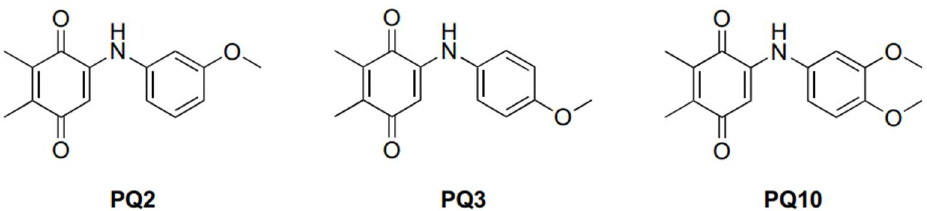
Figure 4. Structures of selected PQ analogs involved in the exploration.